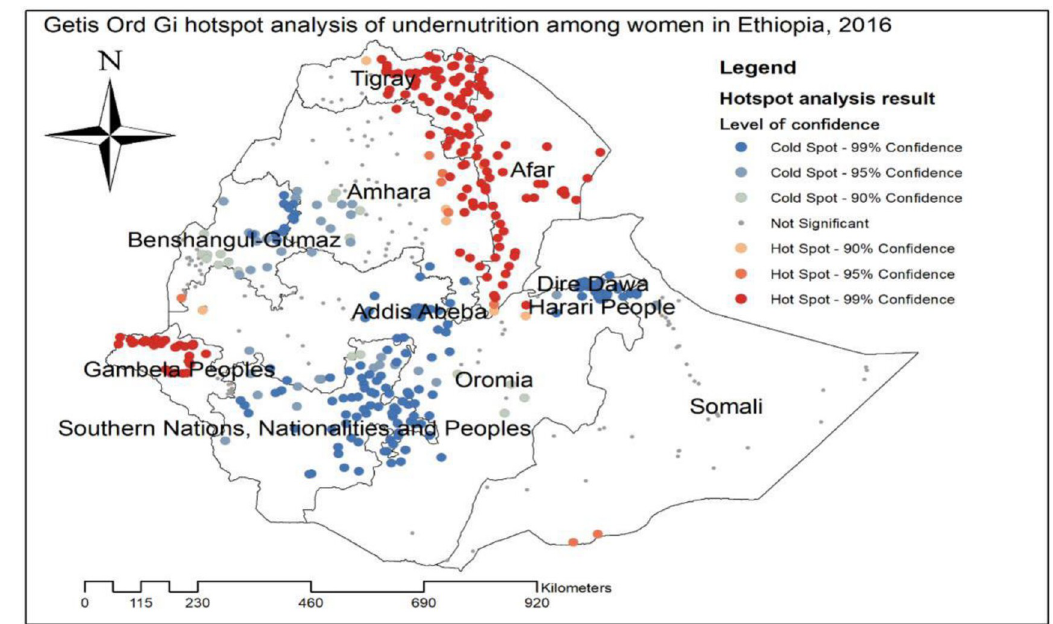
Fig 3. Getis Gi hotspot analysis of undernutrition among women Ethiopia, 2016.